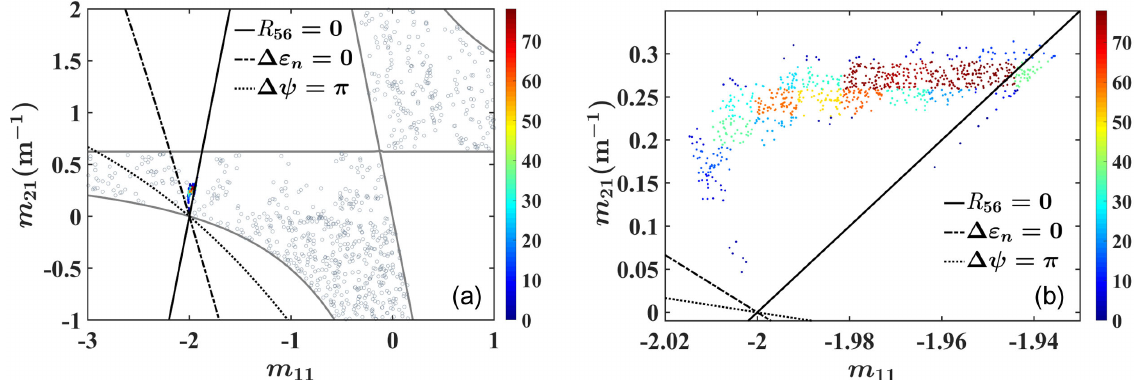
FIG. 6. (a) Distribution of initial seeds (the gray circles), the results of the 2000th generation (dots with color) and the theoretical analysis. (b) Magnified picture of the distribution of the results of the 2000th generation and theoretical analysis. The colors from blue to red represent the distribution of the seeds from sparse to